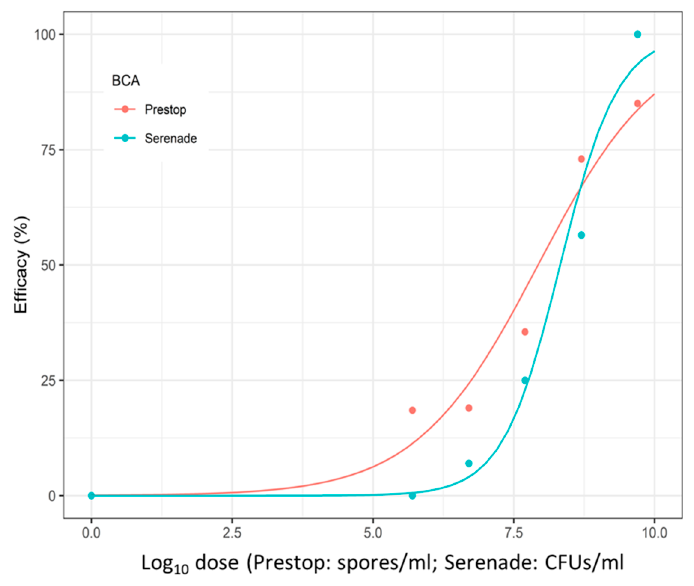
Figure 5. Fitted logistic models describing the dose–response relationship of B. cinerea infection of lettuce leaves in relation to different doses of the two biocontrol (BCA) agents (Prestop and Sere- nade) examined.